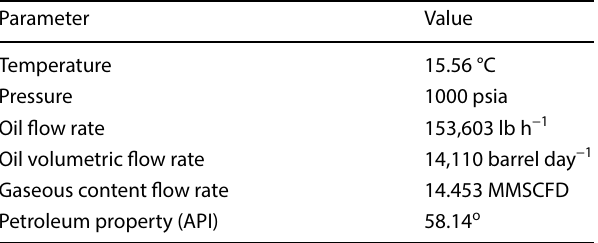
Table 3 Properties of the modelled